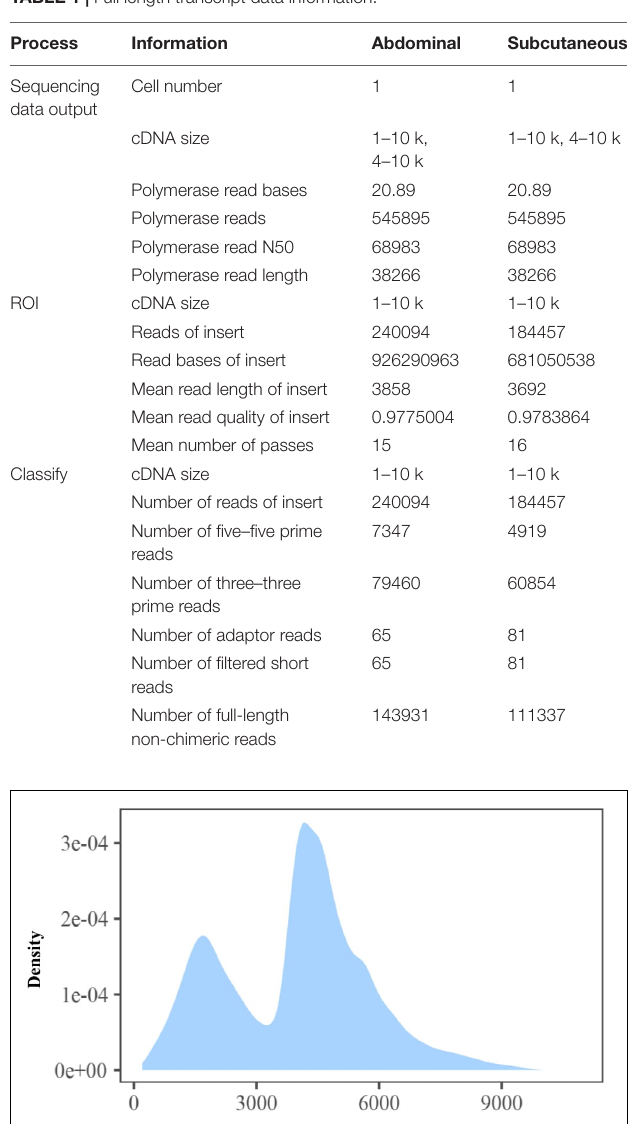
( Figure 3A ), with an average length of 4,469 bp, which is significantly longer than the known length of lncRNAs (1,284